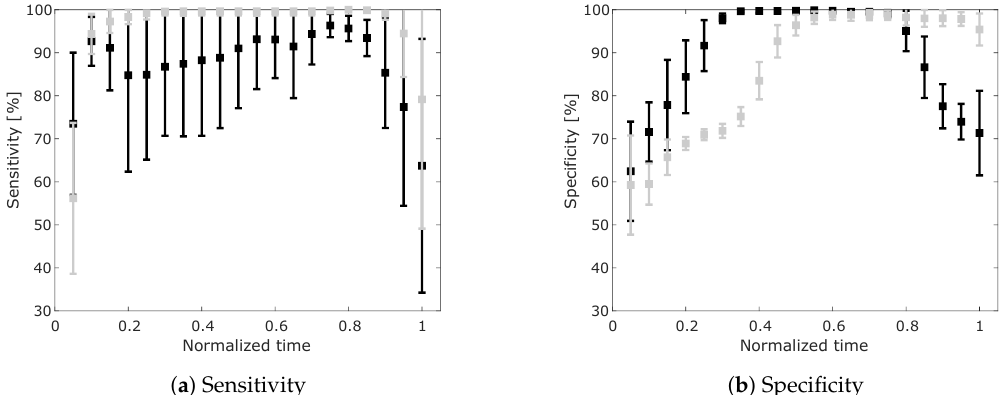
Figure 6. Mean and standard deviation of sensitivity ( a ) and specificity ( b ) over the course of the performed movement for ON/OFF classification. Using only the maximum GMM probability (black) and using GMM+S